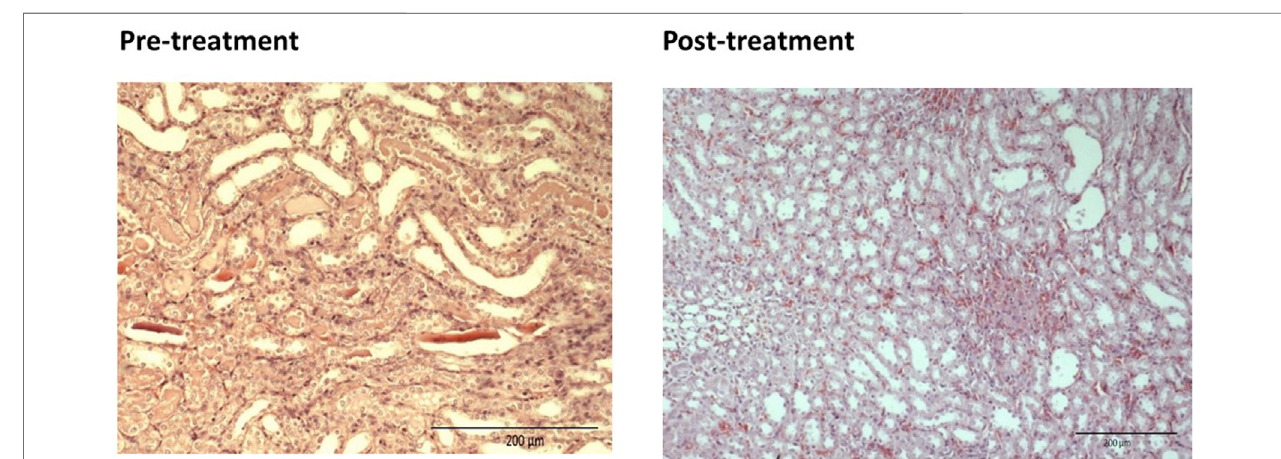
FIGURE 4 | Pre-treatment with EBN 125mg/kg and GTN-relatively normal renal tubles.